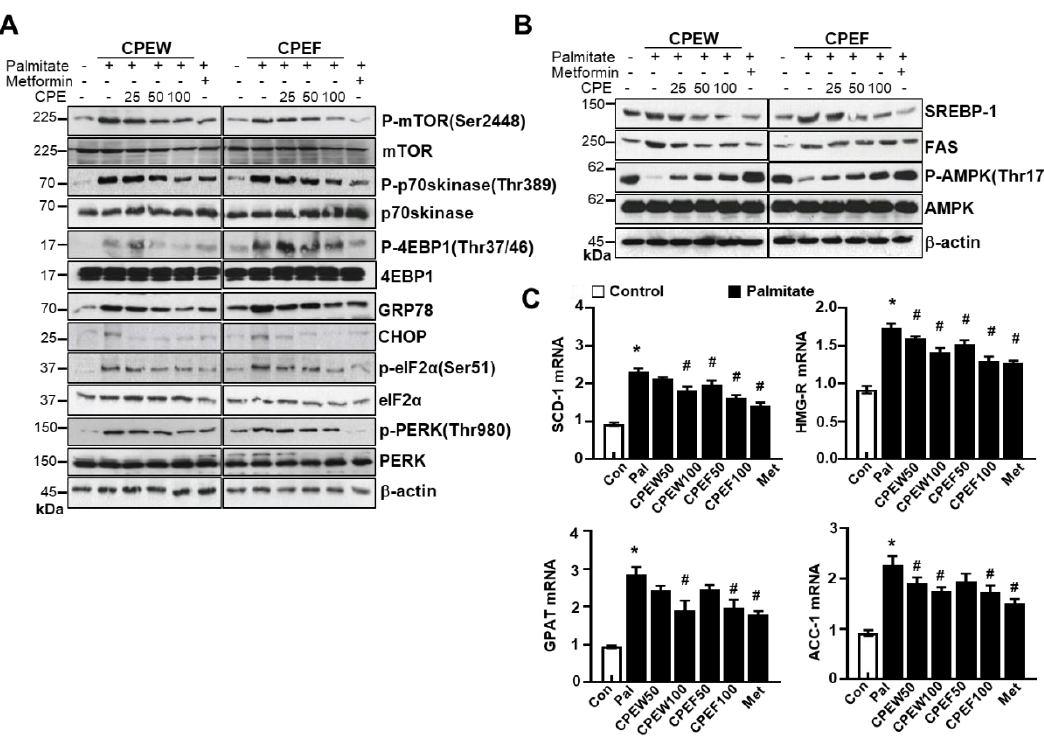
Figure 8. Citrus peel inhibits ER stress in AML12 cells. AML12 cells were treated with the indicated concentrations of 25, 50, and 100 µ g / mL citrus peel, metformin for 24 h for indicated periods, and ( A ) immunoblotting was performed using antibodies against p-mTOR, mTOR, p-p70S6K, p70S6K, GRP78, CHOP, p-PERK, PERK, p-eIF2 α , eIF2 α , and β -actin. ( B ) Immunoblotting was performed using antibodies against SREBP-1, FAS, p-AMPK, AMPK and β -actin. ( C ) mRNA expression levels including stearoyl-CoA desaturase-1 (SCD-1), 3-hydroxy-3-methylglutaryl CoA reductase (HMG-R), glycerol 3-phosphate acyltransferase (GPAT), and acetyl-coenzyme A carboxylase (ACC) were measured as described in Materials and Methods. CPEW, citrus peel extract hot-air dry; CPEF, citrus peel extract freeze-drying.